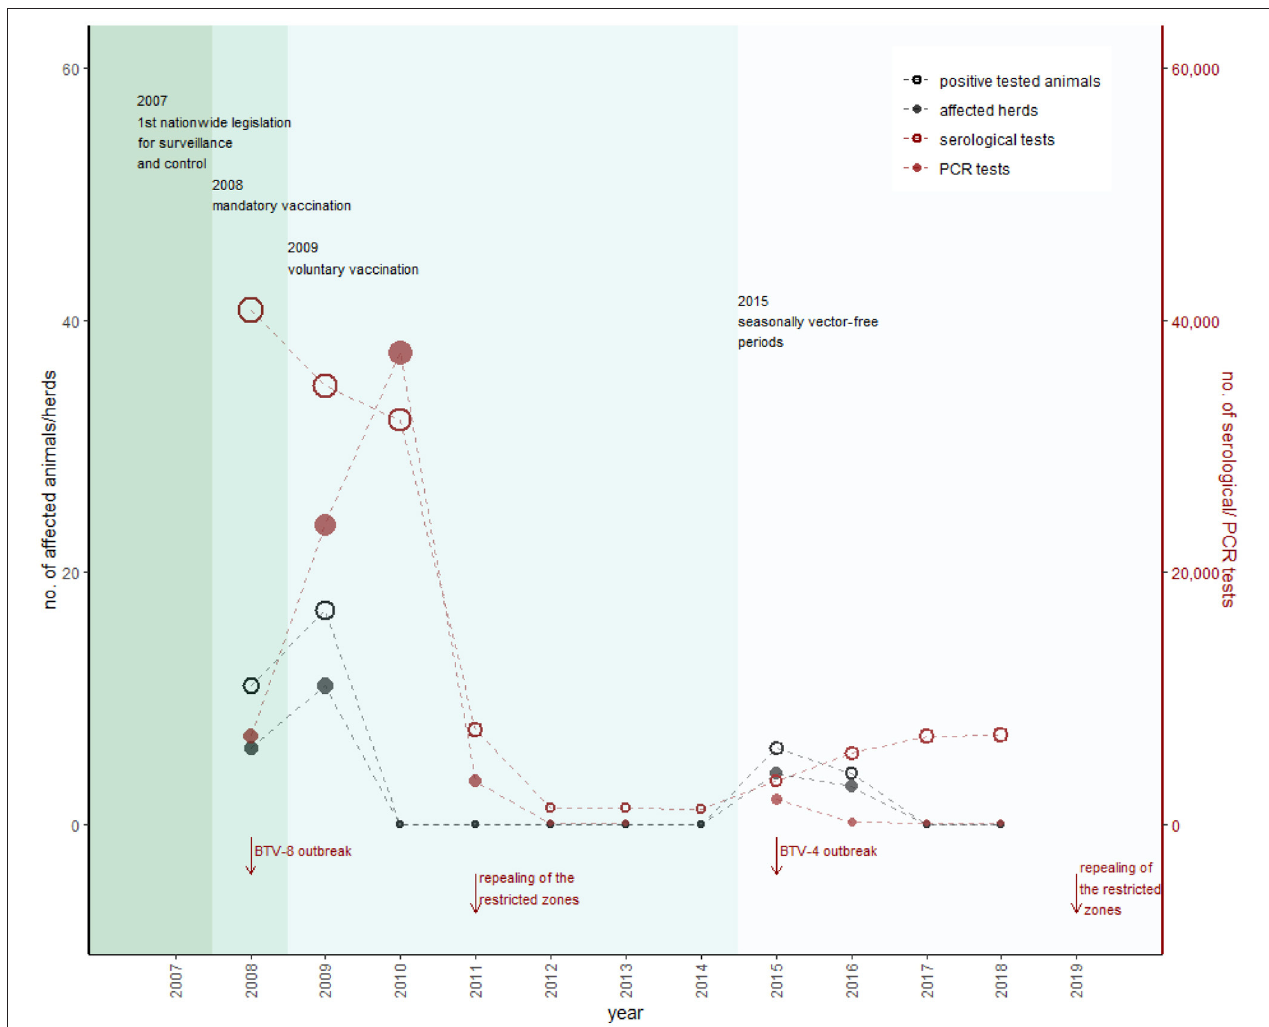
FIGURE 8 | Overview of BT sampling in Austria. Black dots represent the number of positively tested animals (empty) and affected herds with at least one positively tested animal (filled), according to the left y -axis. Red dots show the number of serological (empty) and PCR tests (filled), according to the right y -axis (detailed data are provided in Supplementary Table 3 ). The sampling plan is designed to detect a prevalence of 5% with a 95% confidence level. The most important changes in legislation are represented by the different colors within the figure. In contrast to the other animal diseases, changes in the sampling plan are mainly caused by outbreak events (in Austria and